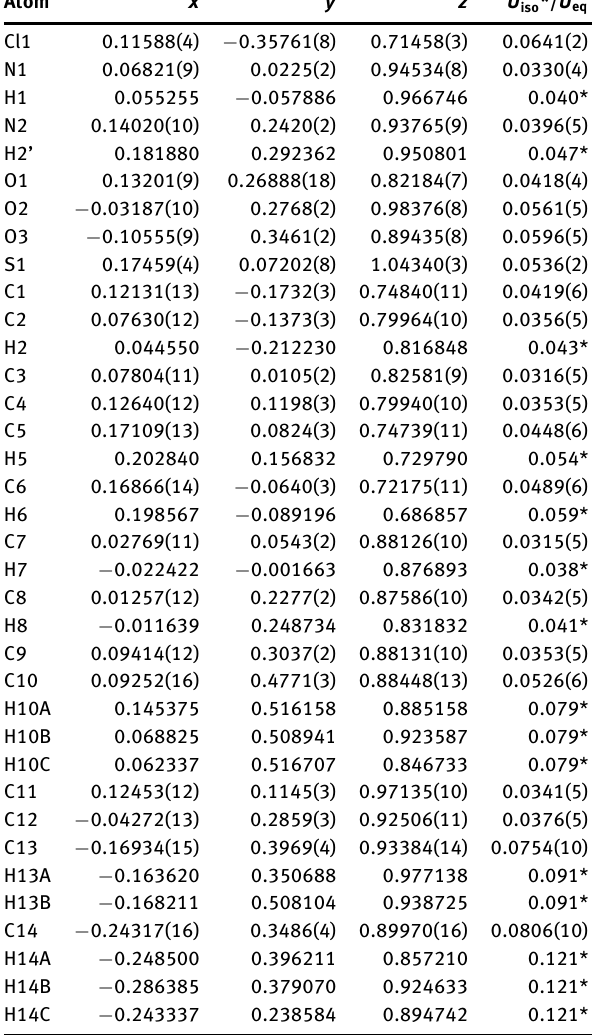
Table 2: Fractional atomic coordinates and isotropic or equivalent isotropic displacement parameters (Å 2